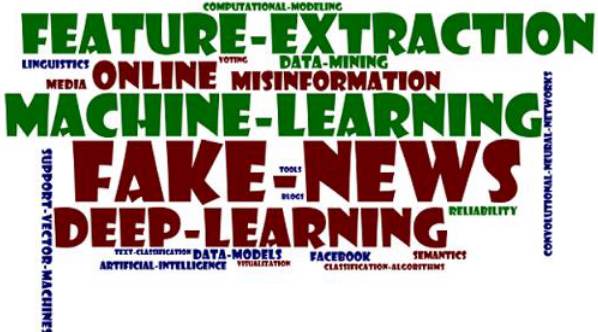
Figure 3. Word cloud of most recurrent keywords in articles Source: The authors.